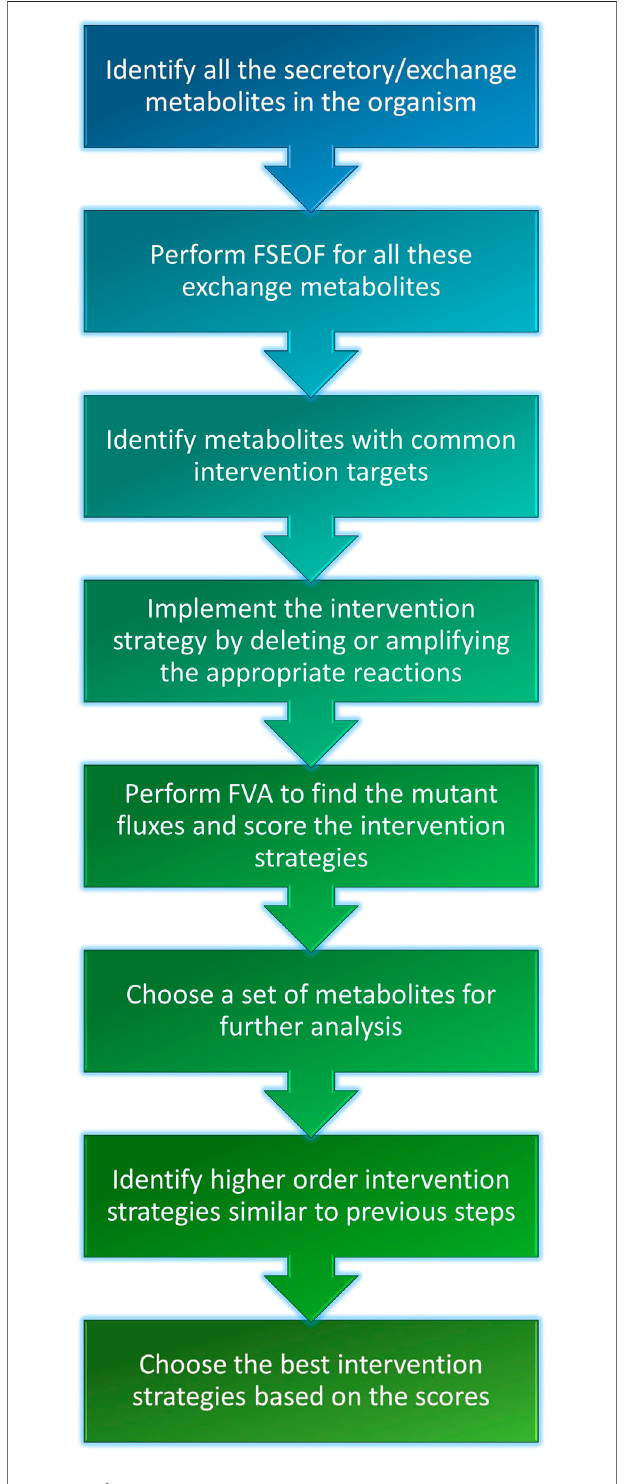
FIGURE 2 | Work fl ow of co-FSEOF. The fi gure illustrates succinctly, the key steps of the